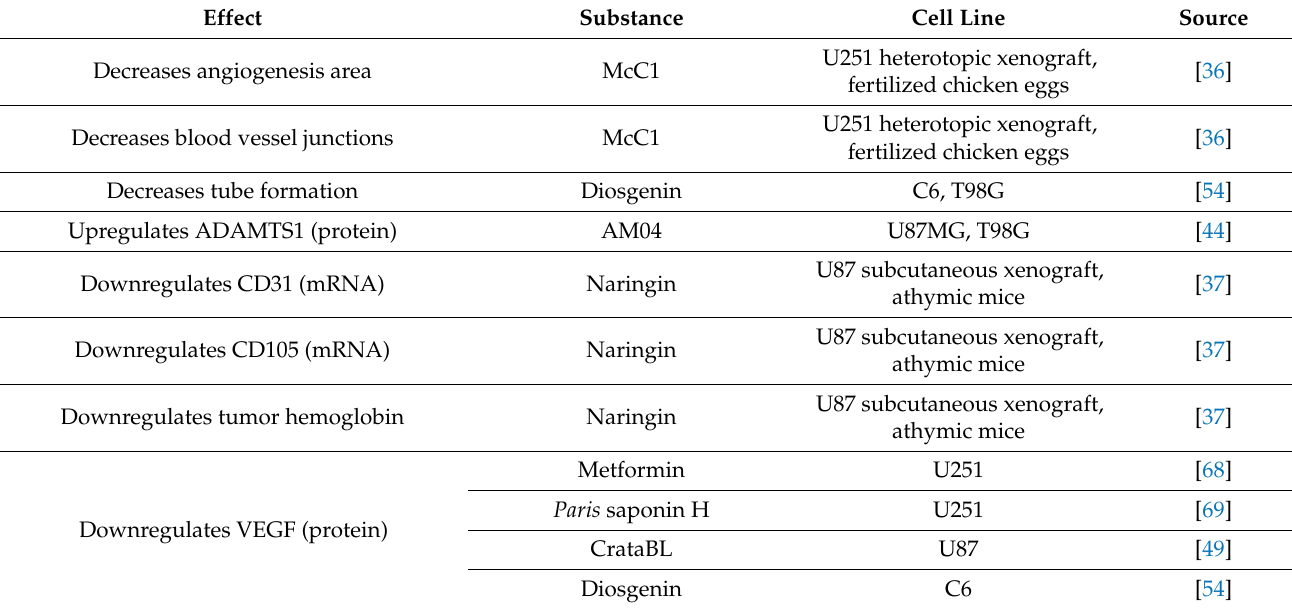
Table 9. Natural substances reduce angiogenesis and neovascularization primarily by downregulating